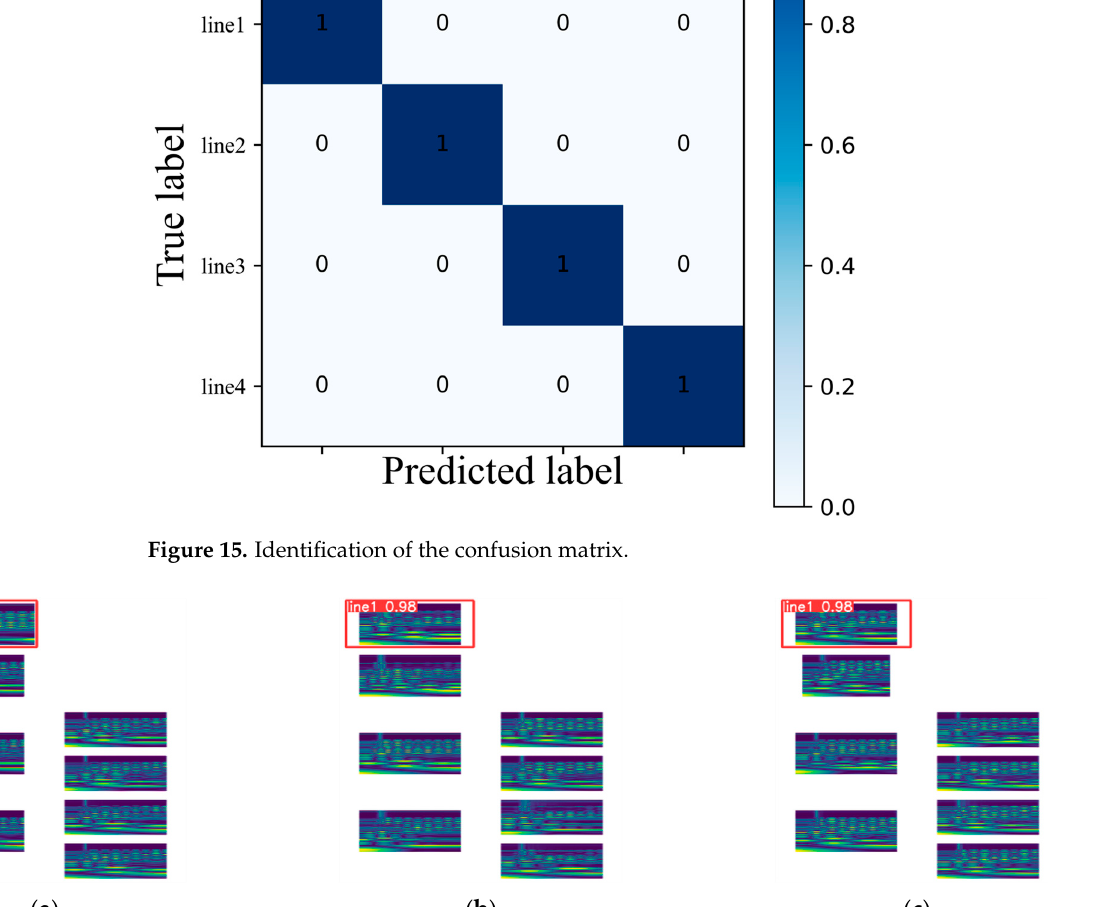
Figure 15. Identification of the confusion matrix.